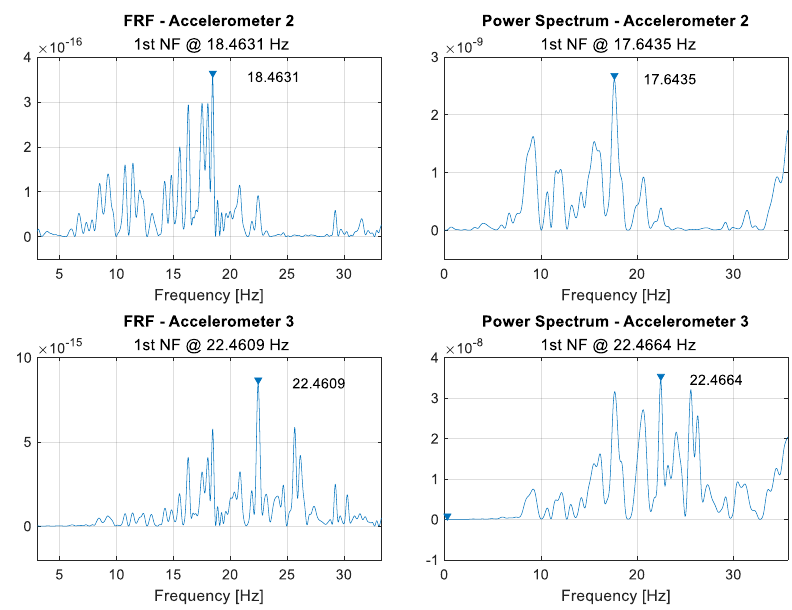
Figure A14. Arduino measurement: 5.0 revolution bolt release.